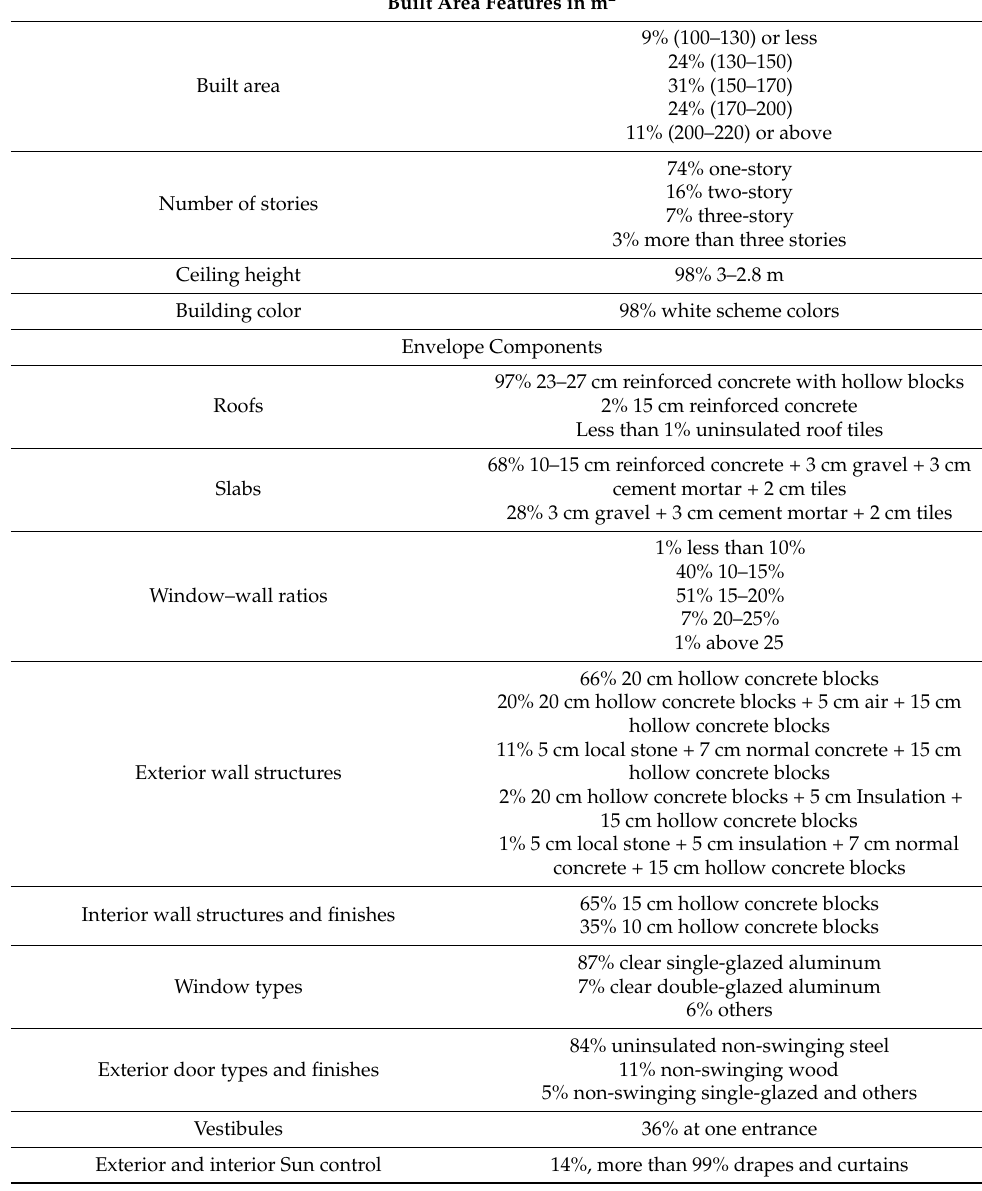
Table 1. Built area features and envelope